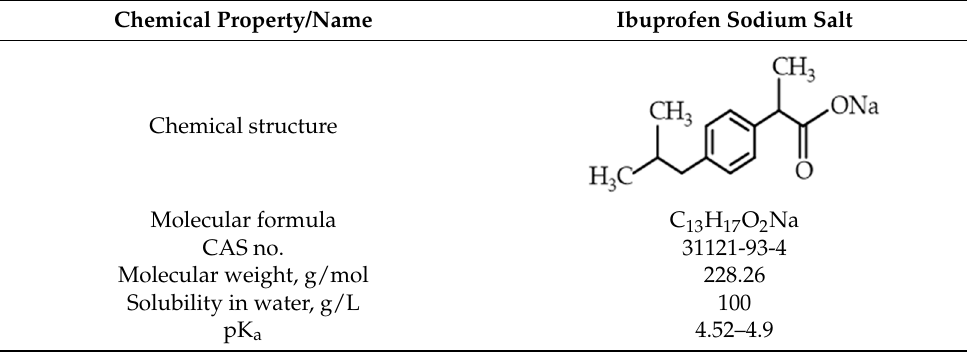
Table 3. Physicochemical properties of ibuprofen (IBU).